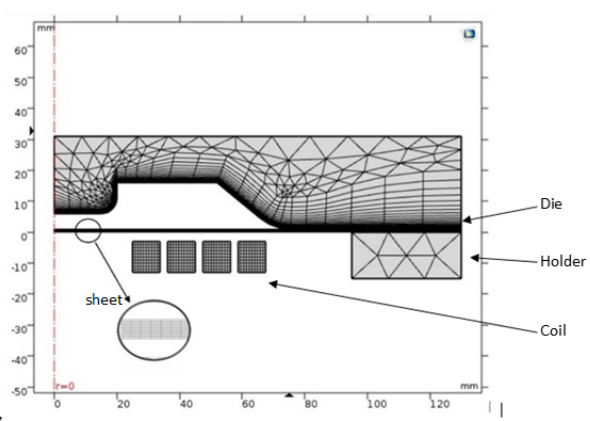
Figure 3. Mesh of EMF closed die for electromagnetic forming of Al